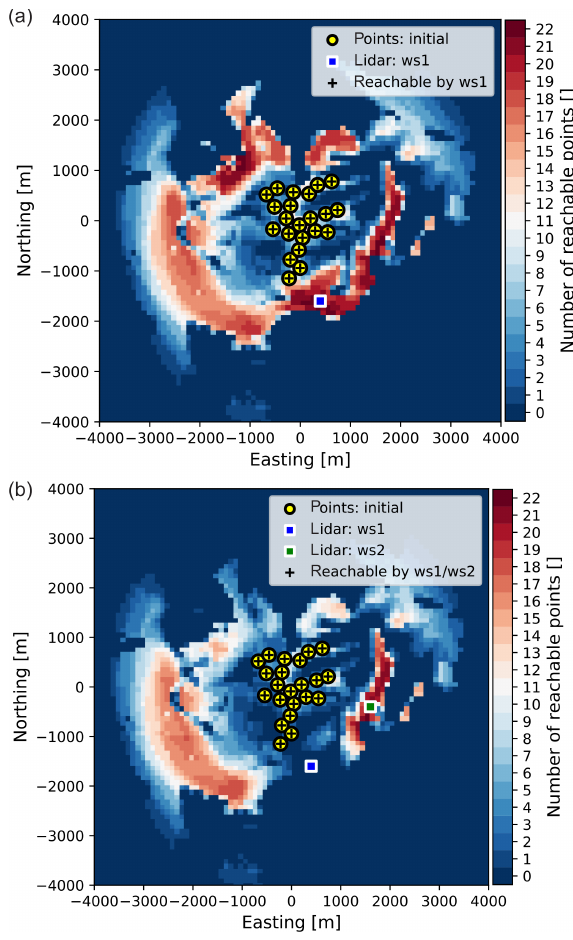
Figure 6. Placing lidars at the Scottish site: (a) locating first lidar at the combined layer; (b) locating second lidar at the second lidar placement layer.